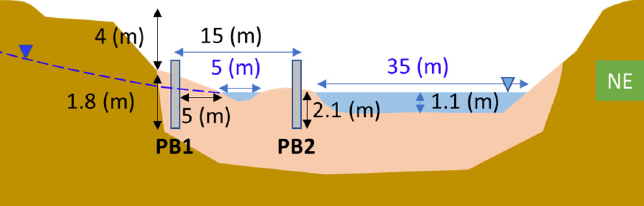
Water 2023 , 15 , x FOR PEER REVIEW Figure 13. Cross section of Berard River at location of piezometers. Figure 13. Cross section of Berard River at location of piezometers.